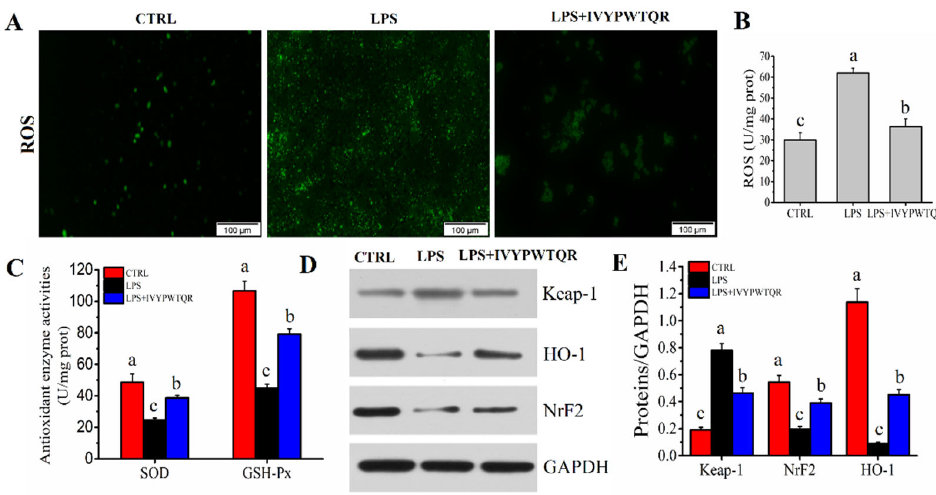
Figure 8. ( A , B ) Effects of IVYPWTQR on the levels of ROS in LPS-mediated RAW264.7 macrophages. ( C ) Effects of IVYPWTQR on the levels of antioxidant enzyme activity in LPS-mediated RAW264.7 macrophages. ( D,E ) Effects of IVYPWTQR on the protein expression levels of Keap-1 , HO-1 , and NrF2 in LPS-mediated RAW264.7 macrophages. Different letters (a, b, and c) in the figure represent significant differences between groups ( p < 0.05).